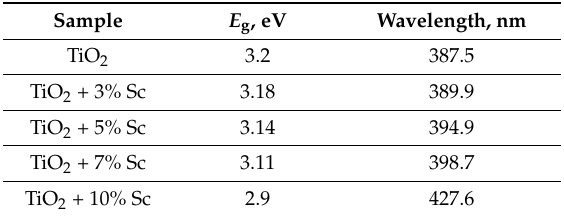
Table 2. Experimental values of the optical forbidden bandgap E g for pure and Sc-doped titania obtained from the Tauc